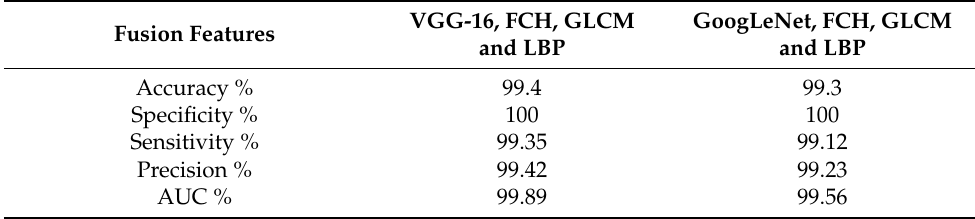
Table 5. Results for the ANN with fusion of CNN with hand ‐ crafted features.